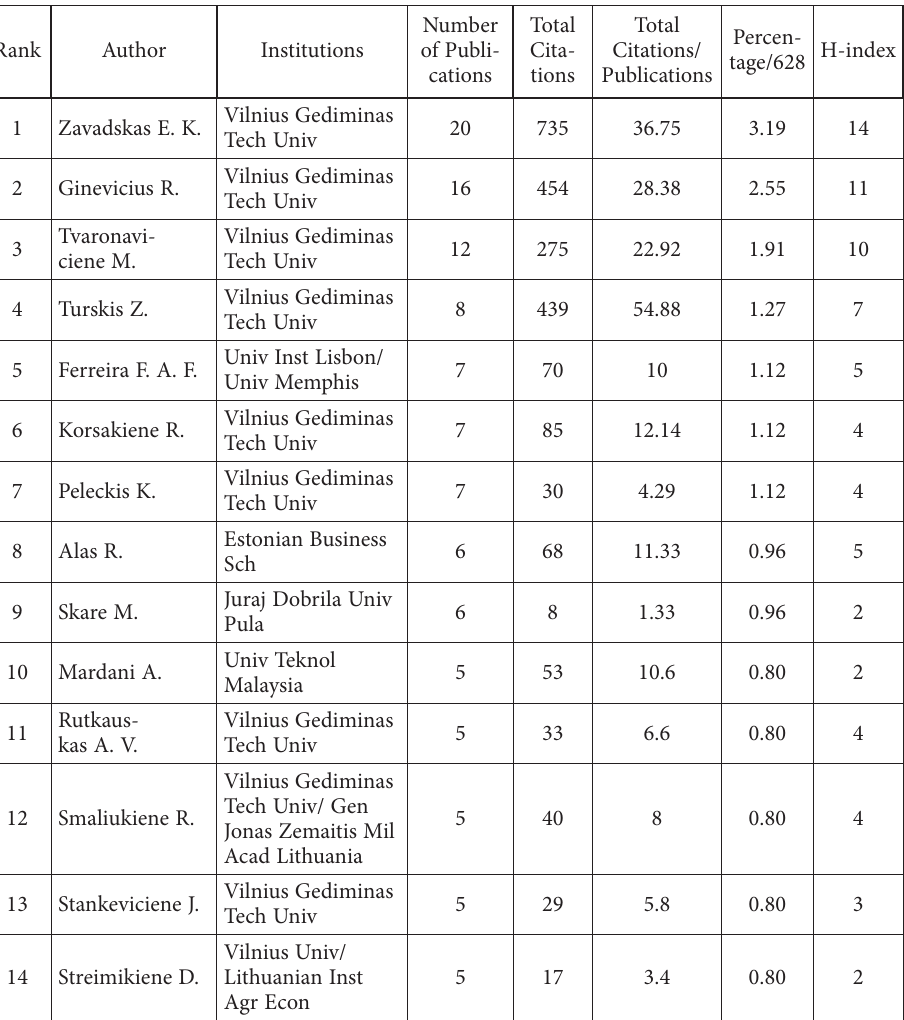
Table 2. Most productive authors of the JBEM with publications